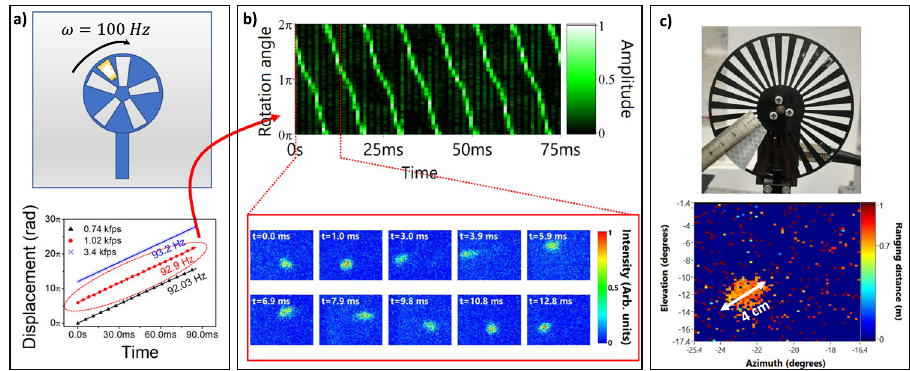
Fig. 5 | Measurement of fast in real-time-series events. a Top: Illustration of the scene: a mechanical chopper of was set up with a nominal speed of 100Hz and some slabs were covered using a re fl ective tape. Bottom: Measurement of the rotationspeedforthreedifferentframerates. b Top:Normalizedintensitymapfor the radial axis, illustrating the dynamics of the wheel. Note the different slope for